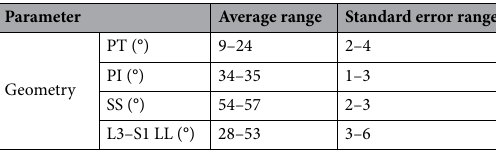
Table 4. Average bony geometry parameter values.